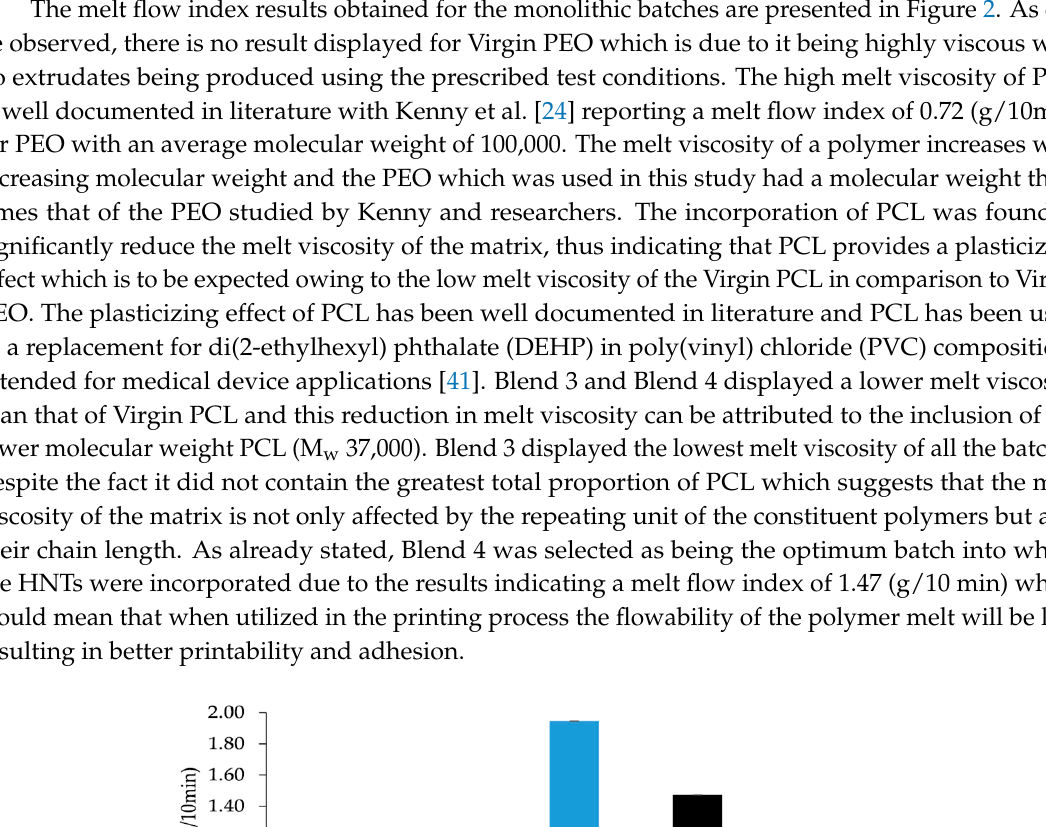
Figure 3. Melt flow index results of nanocomposite batches.